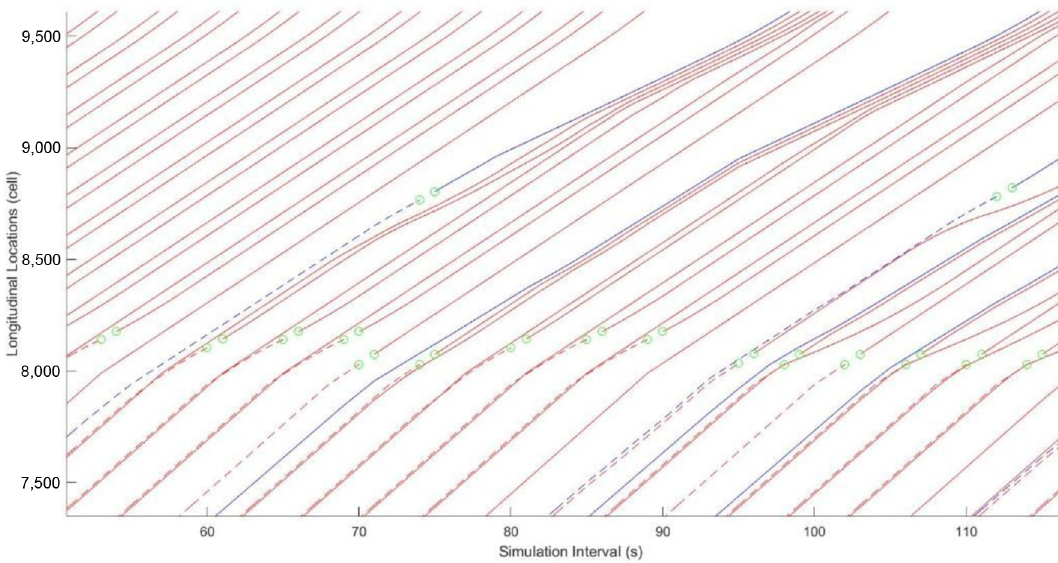
Figure 5 Priority analysis during lane-changing